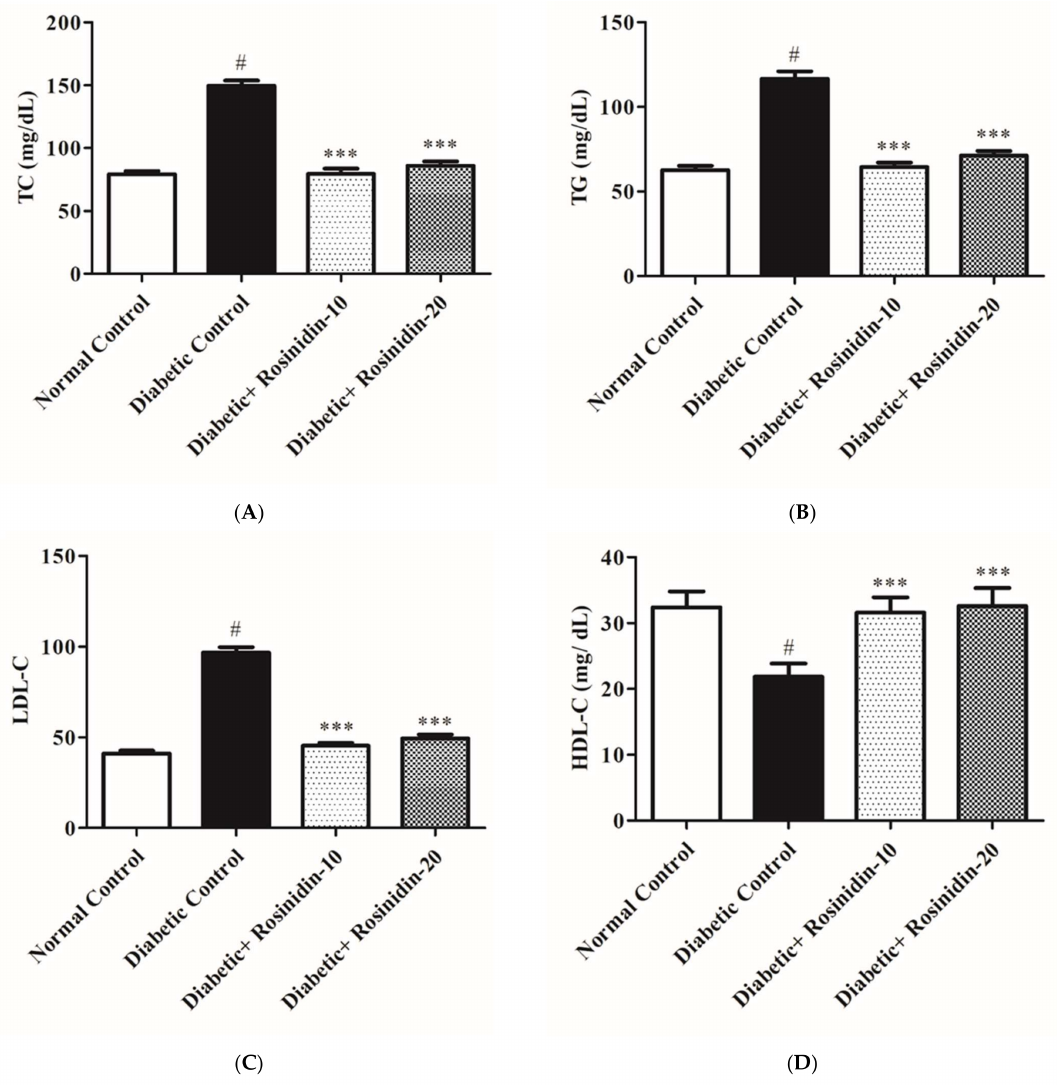
Figure 5. ( A ) Effect of rosinidin on TC against that of STZ-induced diabetic rats ( n = 6). Values are expressed as mean ± SEM. # p < 0.05, normal control vs. diabetic control; *** p < 0.001, diabetic control vs. rosinidin-10, rosinidin-20. ( B ) Effect of rosinidin on TG against that of STZ-induced diabetic rats ( n = 6). Values are expressed as mean ± SEM. # p < 0.05, normal control vs. diabetic control; *** p < 0.001, diabetic control vs. rosinidin-10, rosinidin-20. ( C ) Effect of rosinidin on LDL-C against that of STZ-induced diabetic rats ( n = 6). Values are expressed as mean ± SEM. # p < 0.05, normal control vs. diabetic control; *** p < 0.001, diabetic control vs. rosinidin-10, rosinidin-20. ( D ) Effect of rosinidin on HDL-C against that of STZ-induced diabetic rats ( n = 6). Values are expressed as mean ± SEM. # p < 0.05, normal control vs. diabetic control; *** p < 0.001, diabetic control vs. rosinidin-10,